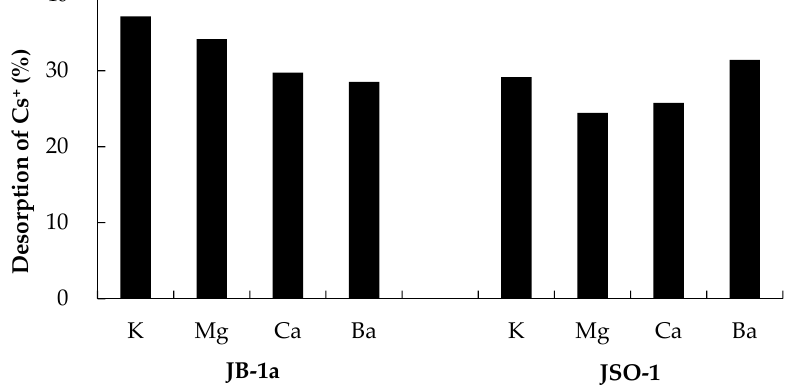
Figure 7. Desorption ratio (%) of Cs + from JB-1a and JSO-1 (0.5 g) in solutions with coexisting ions (initial concentration: 200 mg/L); the desorption ratios were calculated based on the Cs + adsorption quantities in the absence of the coexisting ions (Figure 2).